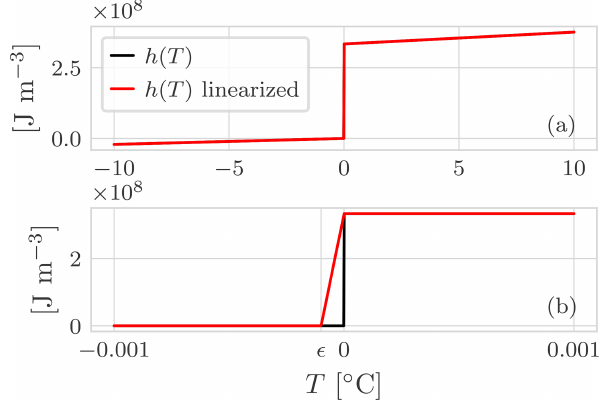
Figure E1. (a) Comparison between the enthalpy function of pure water and the enthalpy function used in the numerical model. (b) Note that the energy jump due to the latent heat at T m = 0 ◦ C has been linearized, and the steepness is controlled by the parameter (cid:15)